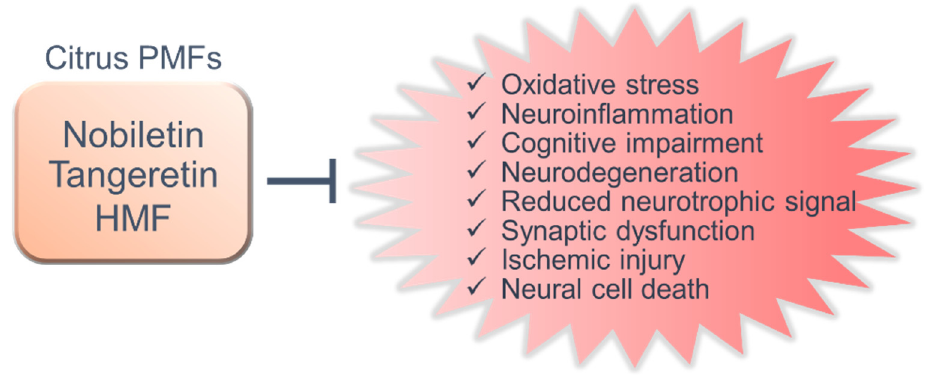
Figure 3. Potential therapeutic mechanism of nobiletin, tangeretin and 3,3 ′ ,4 ′ ,5,6,7,8-heptamethox- yflavone (HMF) for central neurological diseases. neurological